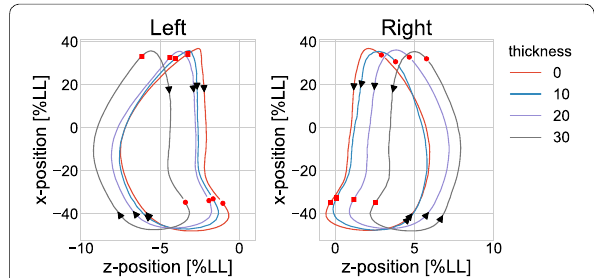
Fig. 10 Horizontal relative foot positions to pelvis during running. These positions were relative ones to the pelvis position. The red circles and the red square represent right and left heel strike, respectively. The arrows represent the direction of foot motions. This figure demonstrates that runner with 20 mm thick and 30 mm thick blocks moved foot in lateral direction